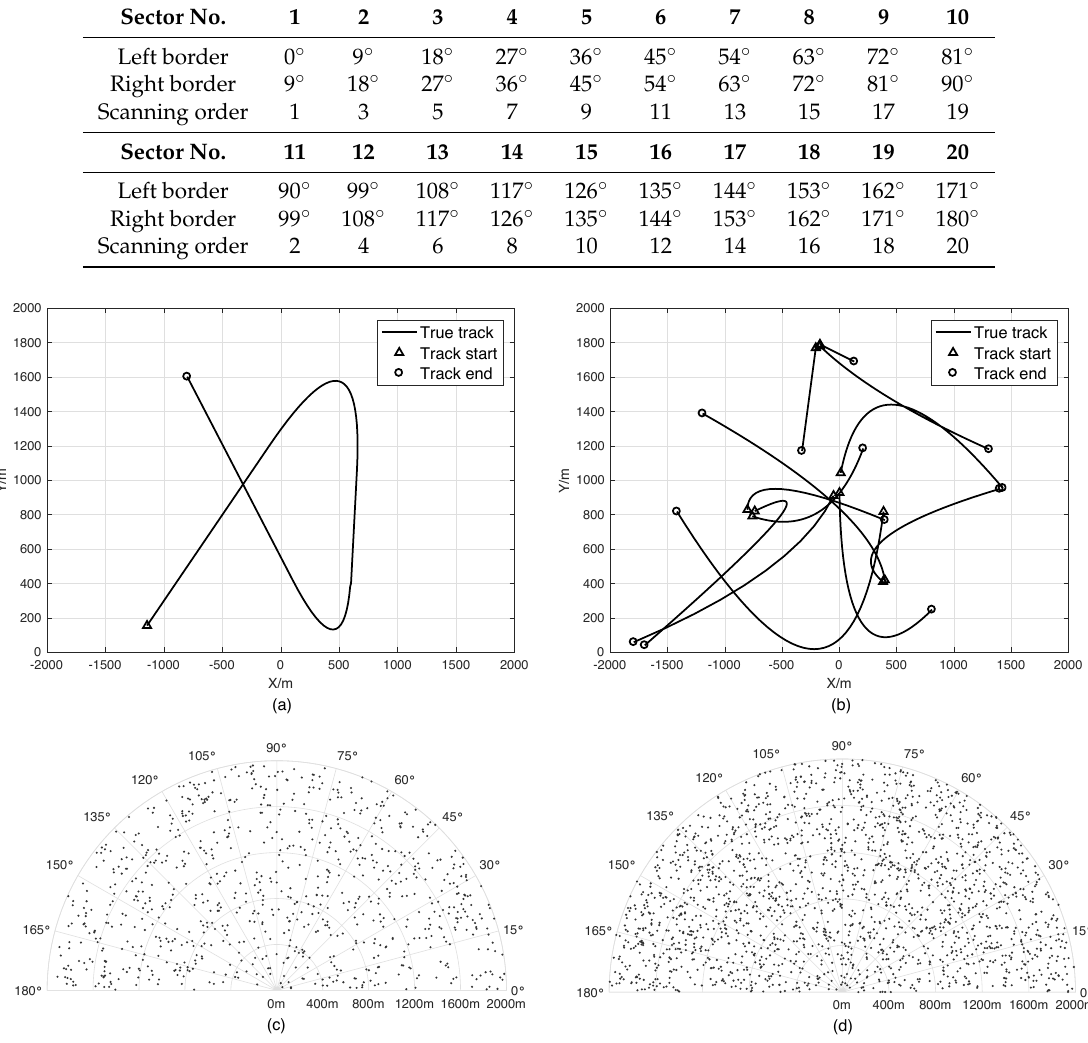
Figure 1. True trajectories of targets and clutters. ( a ) Target trajectories in Scenarios 1 and 2. ( b ) Target trajectories in Scenarios 3 and 4. ( c ) Clutter distribution in Scenarios 1 and 2. ( d ) Clutter distribution in Scenarios 3 and